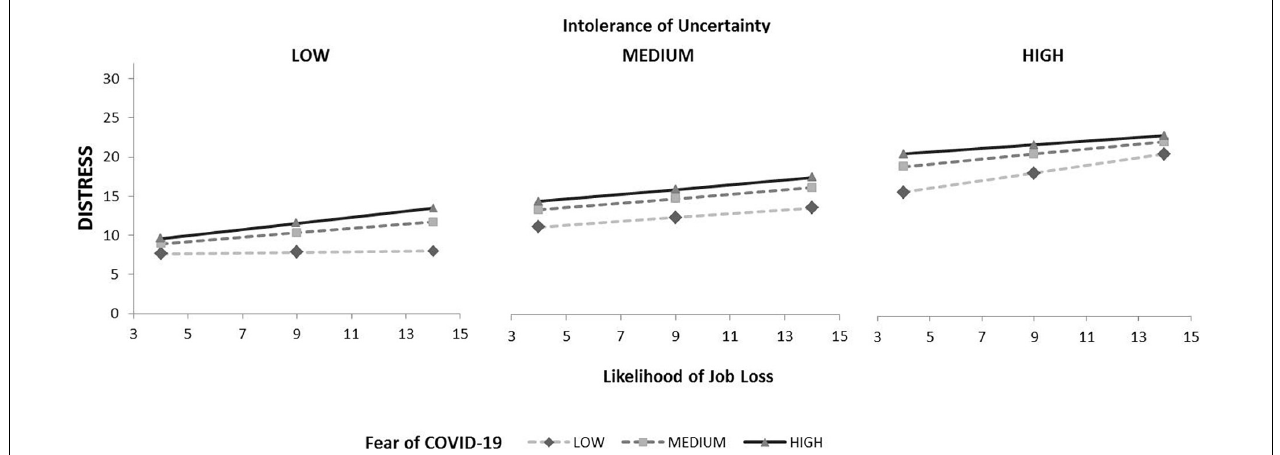
FIGURE 3 | Interaction of intolerance of uncertainty, fear of COVID-19 and likelihood of job loss affect distress score.